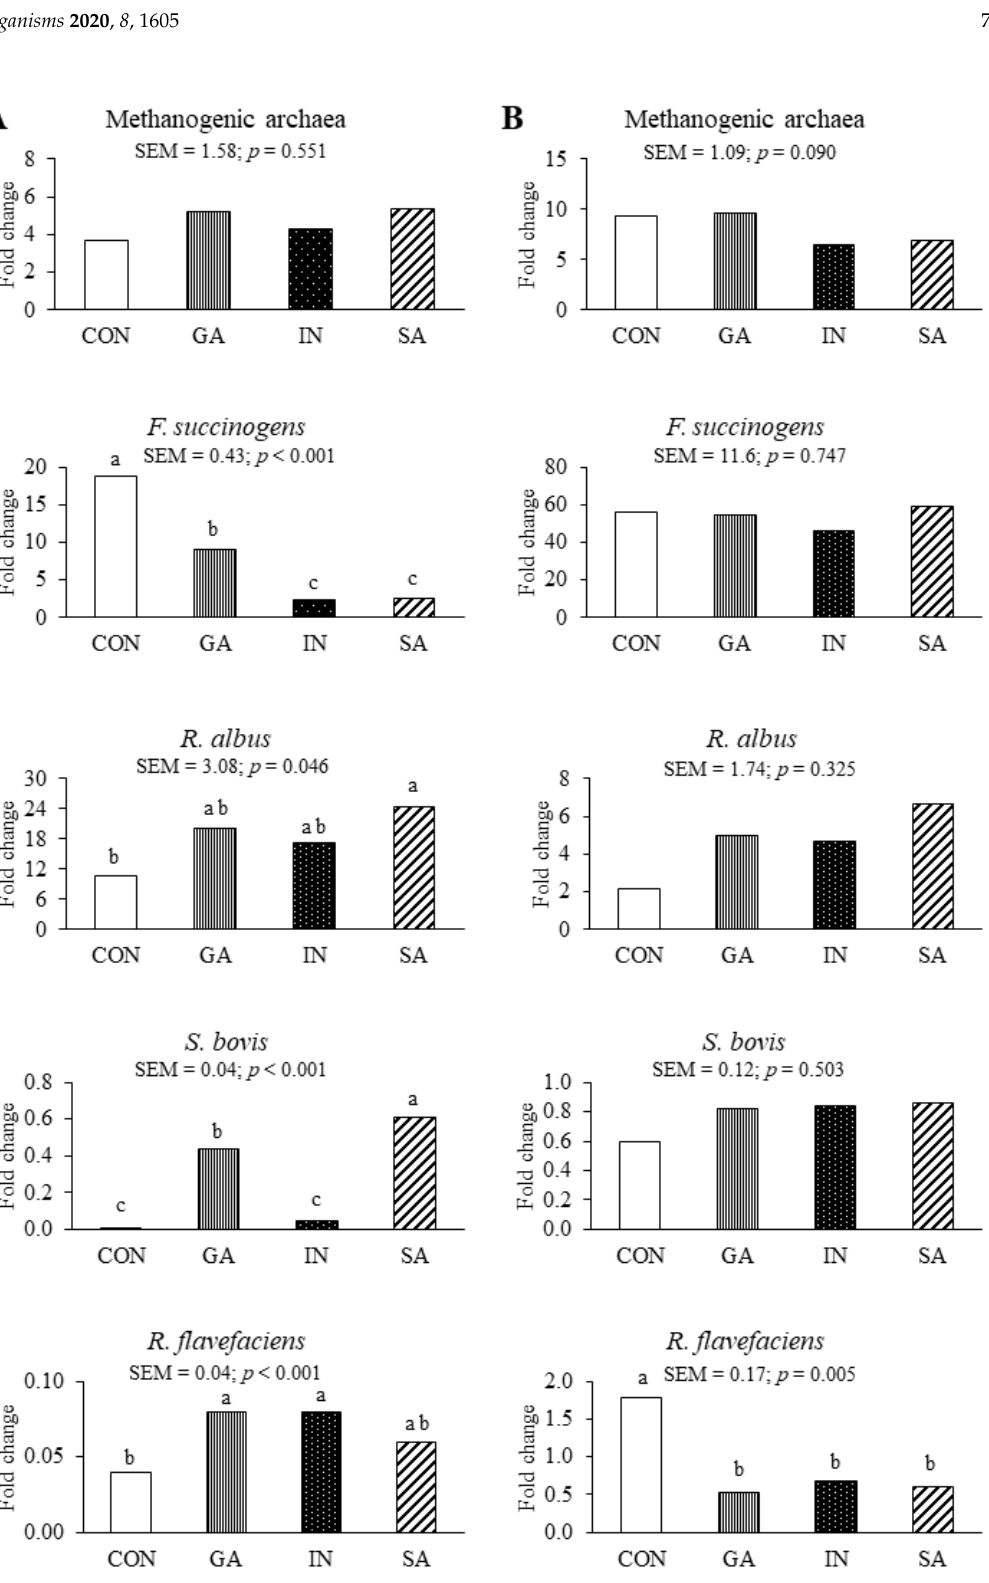
Figure 1. Effects of adding essential oils from different wormwood species to soybean meal (SBM) ( A ) or bermudagrass hay (BGH) ( B ) on fold changes of rumen microbial populations compared to that of the blank after 72 h of in vitro incubation in buffered rumen fluid. CON, without essential oil application; GA, Ganghwa essential oil applied; IN, Injin essential oil applied; SA, San essential oil applied. a–c: Means for the same microbe with different letters differ significantly ( p < 0.05).